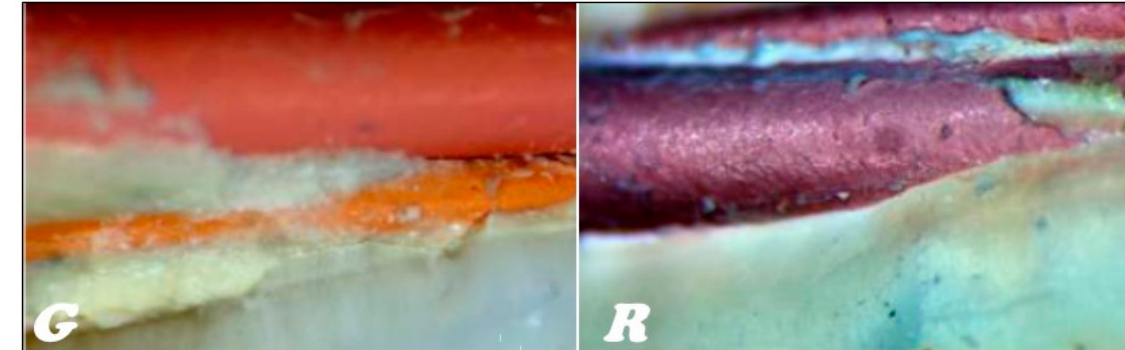
Figure 17. Middle section of the root canal sealed by cold lateral condensation ( G ) using gutta ‐ percha studs with a thick intermediate layer of sealant on the border of the dentin of the root canal and complementary studs and a thick intermediate layer of sealant on the border of the complementary studs and the central stud with visible leak ( R ) connection of the main stud made of resilon with the additional stud; LSM.